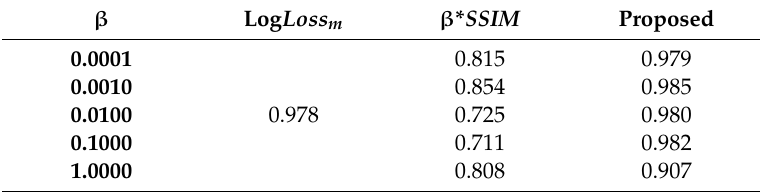
Table 5. Performance of loss function based on the proposed loss function.